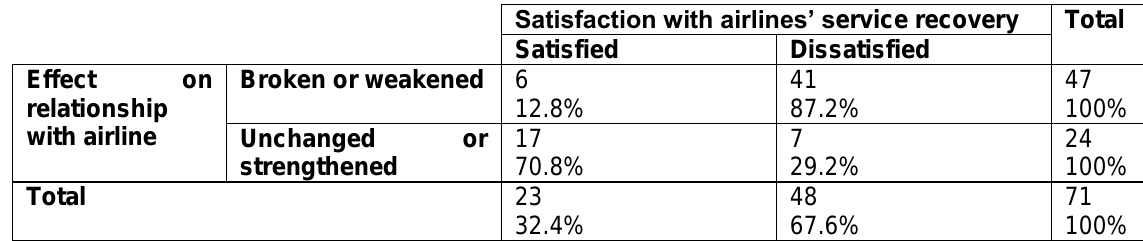
Table 4: A cross- tabulation between respondents’ satisfaction with the airlines’ service recovery and the effect on their relationship with the airline Satisfaction with airlines’ s ervice recovery Total Satisfied